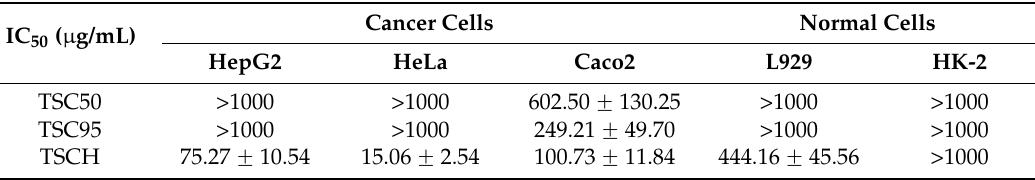
Table 2. Mitochondrial dehydrogenase activity of various tamarind seed coat extracts. IC 50 ( µ